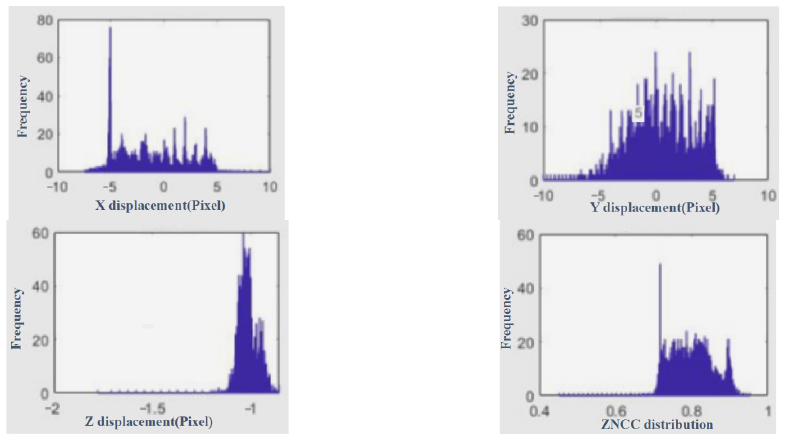
Figure 14. DVC computation of x, y, and z direction displacement and ZNCC distribution histo-